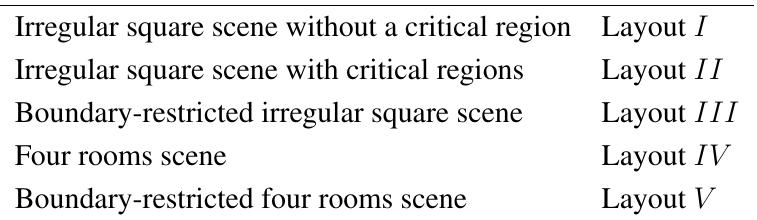
Table 4. List of the sequence number for cameras